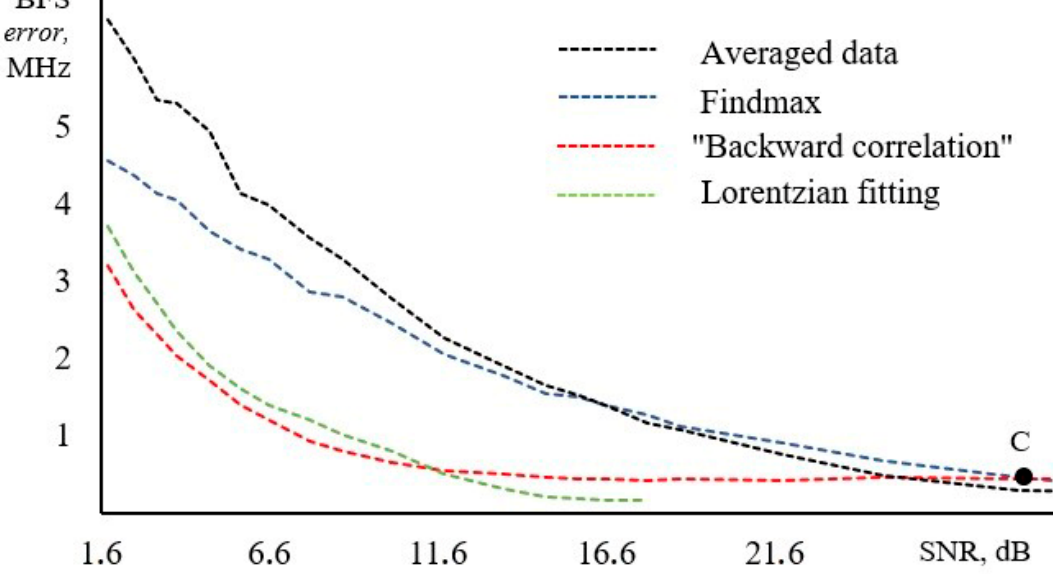
Figure 2. Comparison of di ff erent methods for finding the maximum of the Brillouin gain spectra (BGS) for frequency scanning step 1 MHz: Absolute error in finding the frequency (MHz) versus the signal-to-noise ratio (SNR) of the original spectrum, dB. Data on Lorentzian fitting is taken from